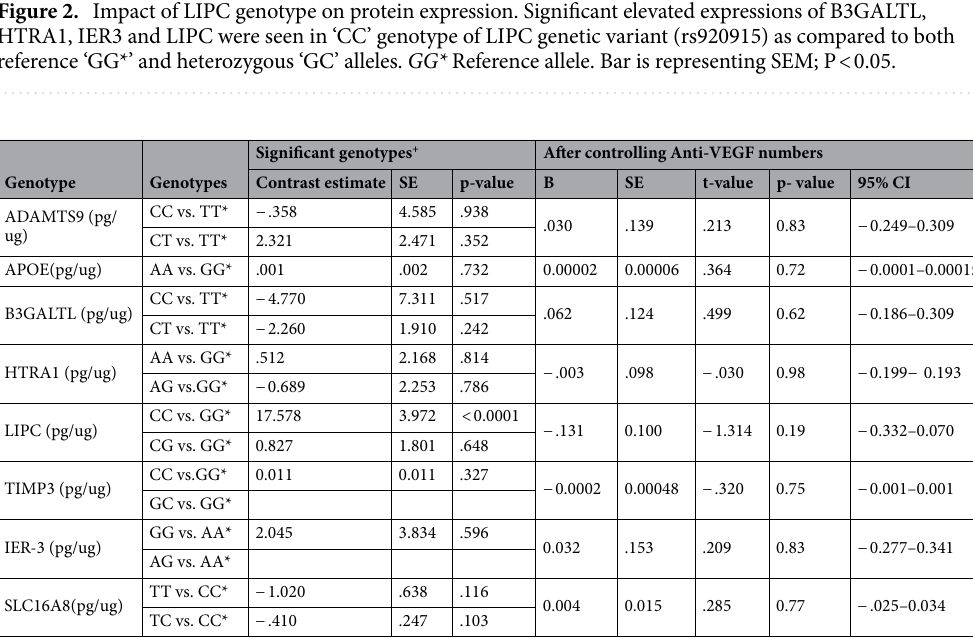
Table 4. Contrast estimate to see the impact of genotype and response of anti-VEGF in AMD. Contrast estimate indicates the significant of per unit change in genotype (nucleotide/polymorphism) from ‘GG’ (reference genotype) to ‘CC’ in LIPC genetic variant (rs920915) by alteration the LIPC levels (17.58 pg/unit changes). Alteration in expression levels with reference by changing in nucleotides (‘GG’ to ‘CC’) didn’t show any alterations indicating the indirect implication of anti-VEGF injections in AMD pathology (by considering the anti-VEGF numbers as